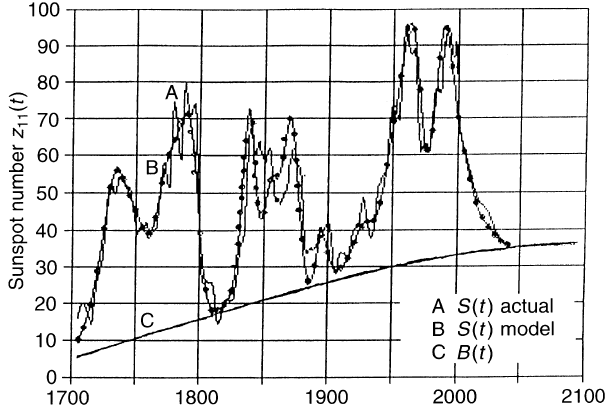
Fig. 5. Surges (actual and model)